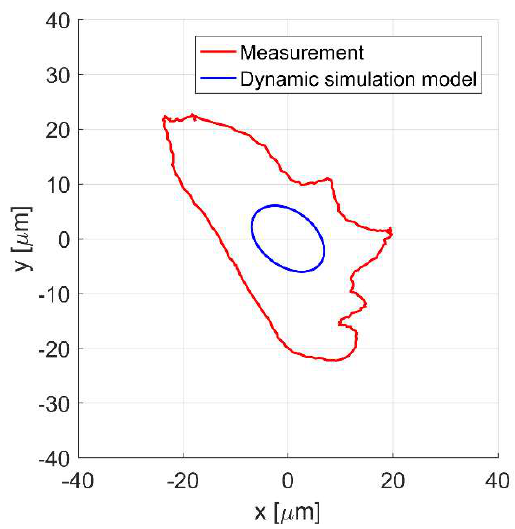
Figure 10. The rotor position in x and y axes for the rotor rotation with 4724 rev/min.